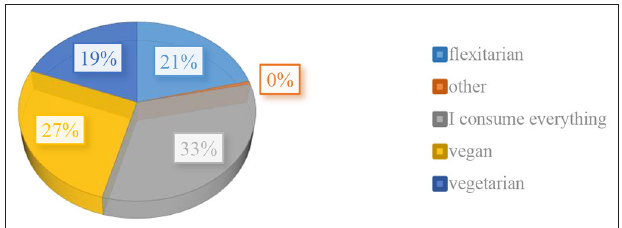
FIGURE 3 | Form of diet (in %). Source: Results of the questionnaire survey.